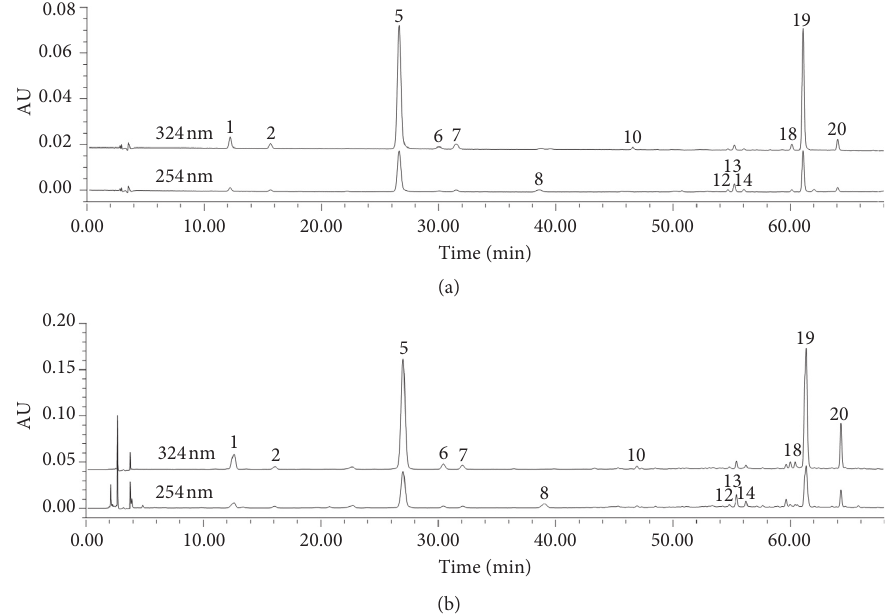
Figure 5: HPLC chromatograms of the mixed reference substances (a) and A. capillaris sample (b). The number of peaks is the same as Table